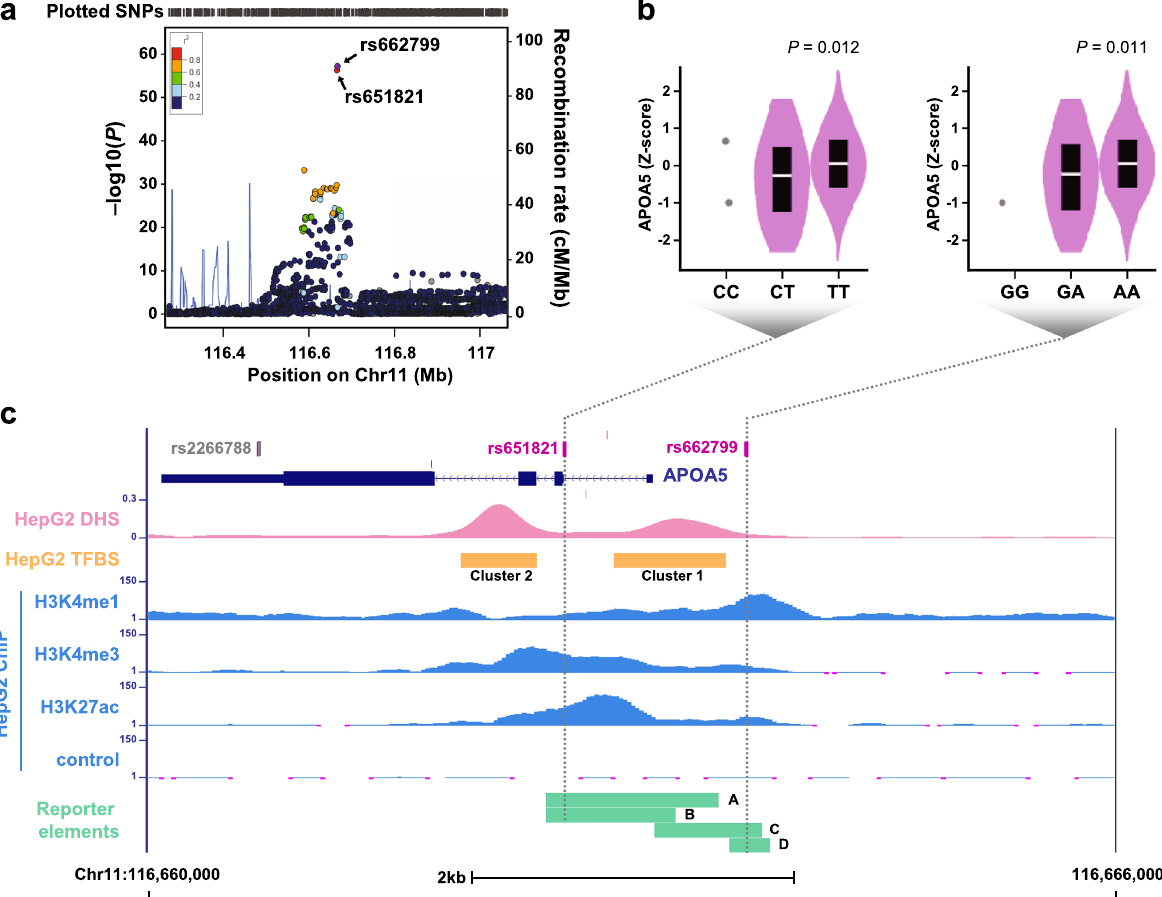
Fig. 2 Integrated analyses to prioritize the causal variant at locus 11q23.3. a Regional association plot for hyperlipidemia in association with the top SNP rs662799 (purple diamond). The other GWAS-detected/imputed SNPs are displayed by color showing their degrees of linkage ( r 2 ) with rs662799. b The eQTL correlation between APOA5 expression and the rs651821 genotype (left) or rs662799 (right) in liver tissues, for which the plot and P values were queried from the GTEx Portal. c Visualization of epigenetic regulation in HepG2 cells including histone modi fi cations, DNase hypersensitivity region (DHS), and transcription factor binding sites (TFBS) upstream of APOA5 (UCSC Genome Browser http://genome.ucsc.edu/cgi-bin/hgPublicSessions, session name: Liver_APOA5p). The locations of the two candidate SNPs (rs651821 and rs662799) as well as the previously described rs2266788 are indicated. DNA fragments used for reporter analysis in the present study are indicated (elements A to